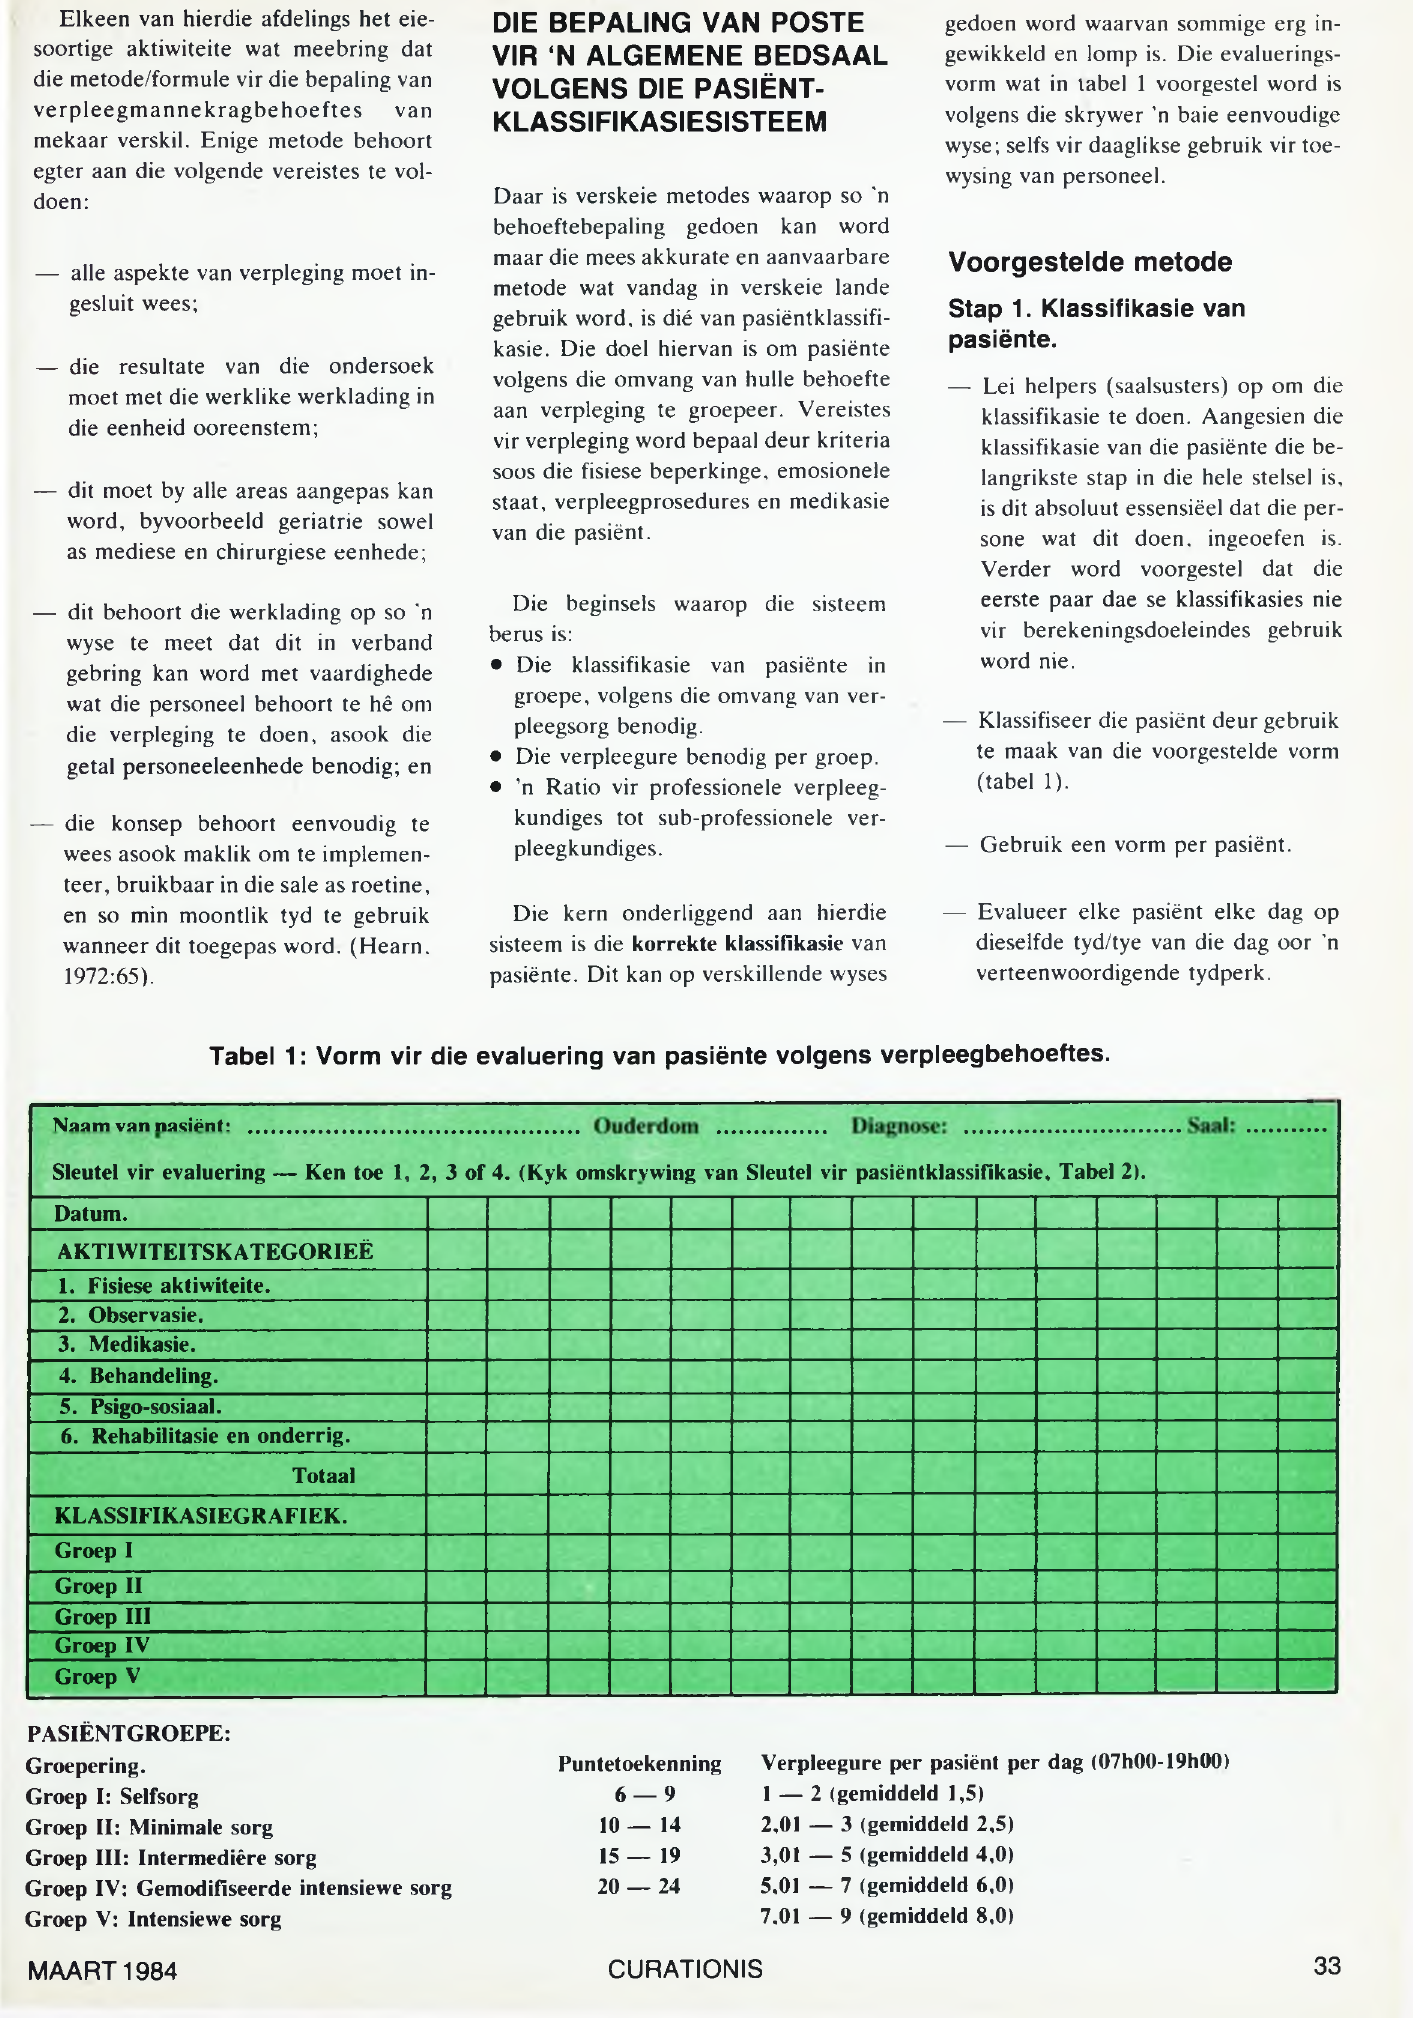
Tabel 1: Vorm vir die evaluering van pasiënte volgens